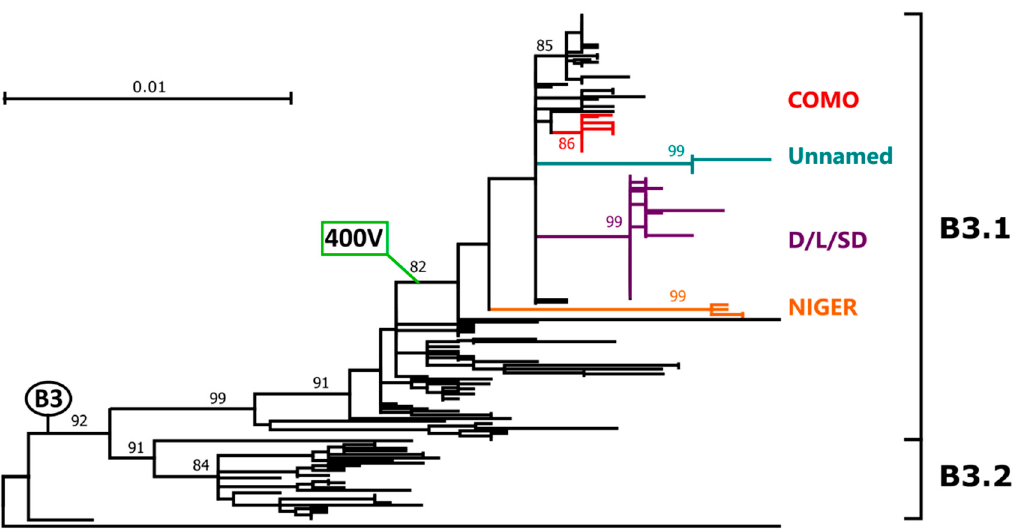
Figure 1. Phylogenetic analysis of genotype B3 full H gene. The tree was obtained with the maximum-likelihood method [27], based on the Kimura 2 parameters model [28], identified as the best-fitting model after the model test analysis, using MEGA X [29]. A discrete Gamma distribution was used to model evolutionary rate differences among sites (+G = 0.2035) and branch support (1000 bootstrap iterations [30]) is provided next to nodes. Sequences from genotypes B1 (MVi/Younde.CAE/12.83) and B2 (MVi/Libreville.GAB/8.84) were used as outgroup. Branches corresponding to genotype (B3), sub-genotypes (B3.1 and B3.2), clade (400V), and clusters considered in this study (COMO, Unnamed, D/L/SD, NIGER) are indicated. Accession numbers of sequences used to generate this tree are available in Supplementary Figure S2.